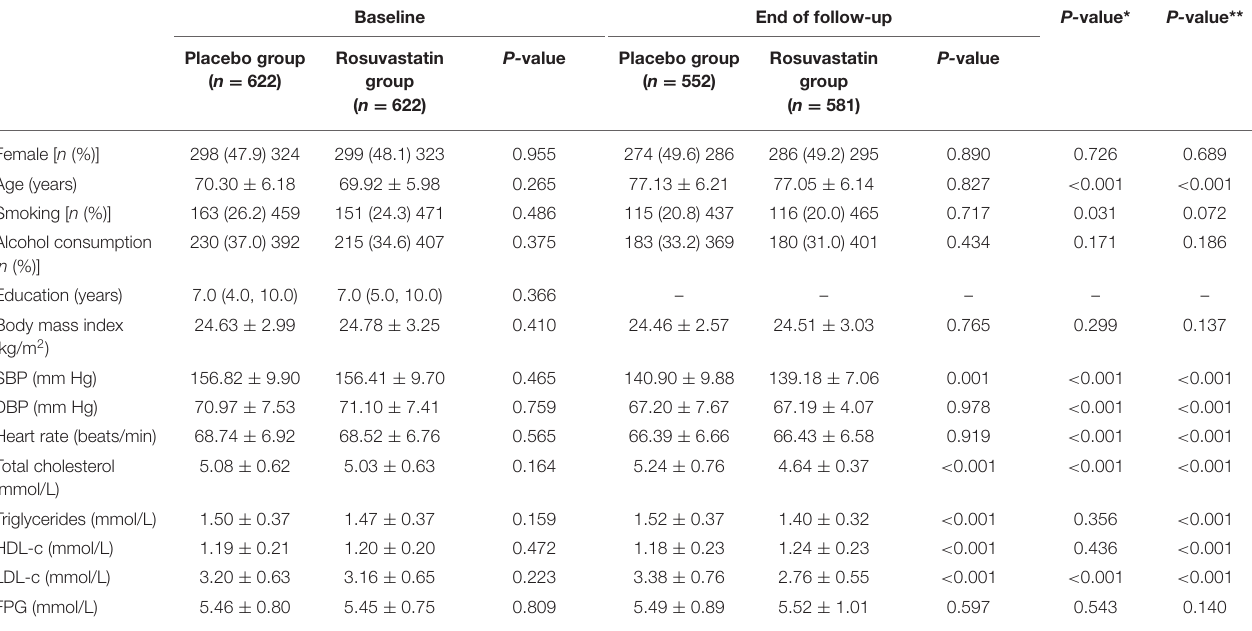
TABLE 1 | Demographic and clinical characteristics at baseline and end of follow-up.